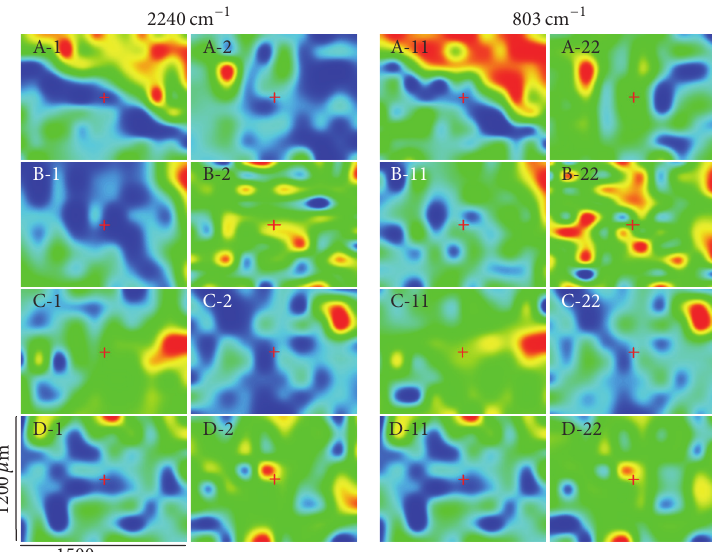
Figure 7: Distribution of FTIR absorption bands characteristic for PAN at 2240 cm −1 (1: skin layer, 2: carrier layer) and for PANI at 803 cm −1